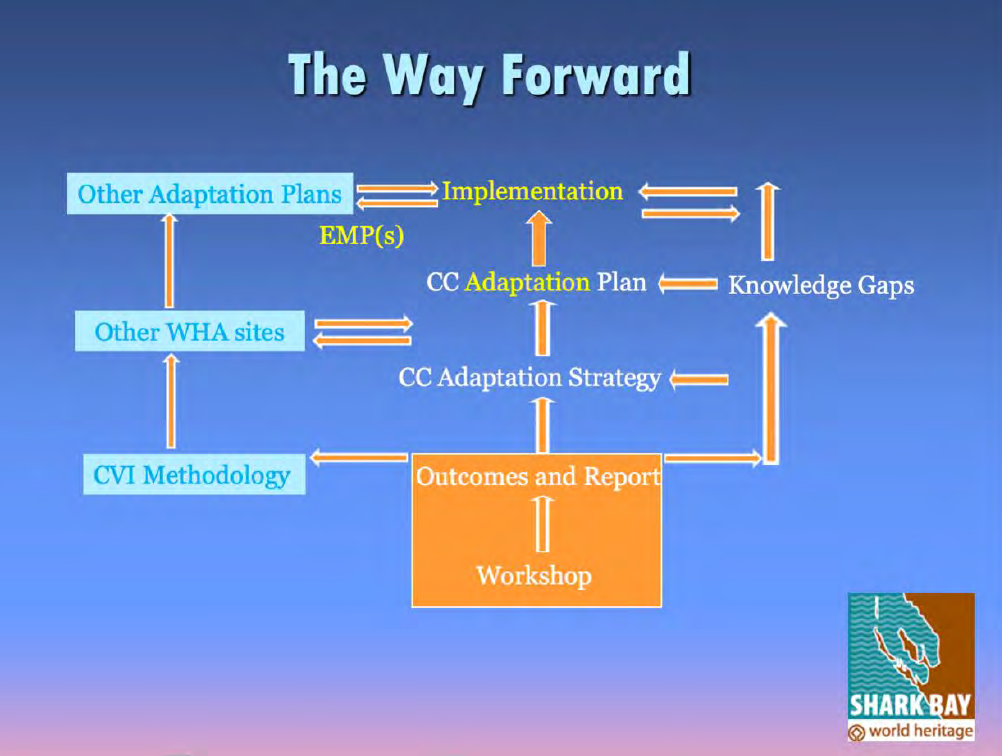
Figure A8.1 Schematic representation of the development of a climate change adaptation strategy and plan incorporating